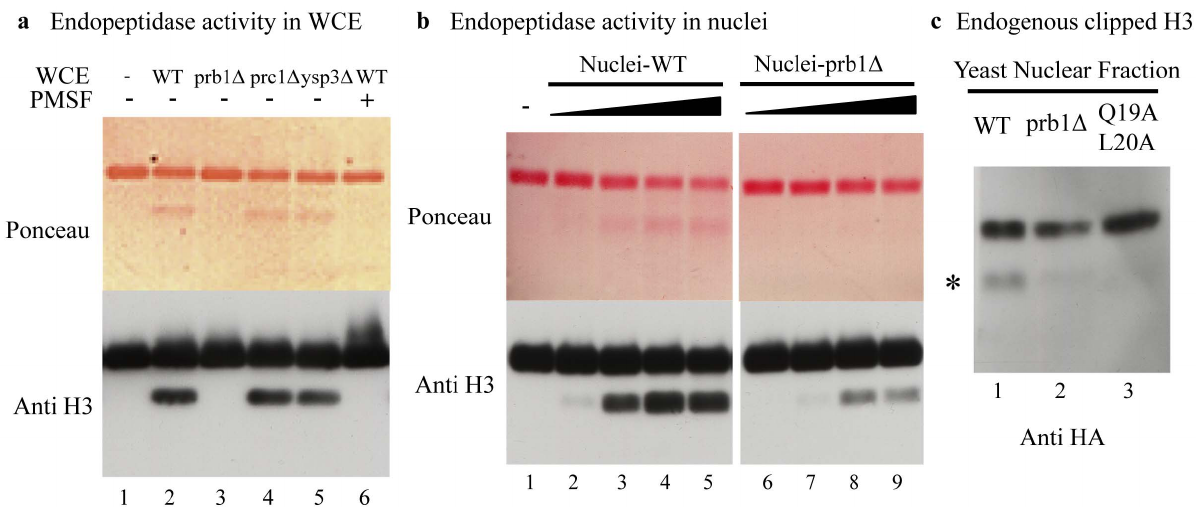
Figure 2. PRB1 is required to cleave histone H3 at its N-terminus invivo. (a) PRB1 is essential for the H3 endopeptidase activity in whole cell extracts of early stationary phase cells. Whole cell extracts from WT, prb1 D , prc1 D and ysp3 D were assayed for endopeptidase activity. Clipping was assayed by western blot with antibody against the H3 C-terminus. (b) PRB1 is required for H3 endopeptidase activity in nuclei. Nuclei from WT and prb1 D cells were assayed for endopeptidase activity. Clipping was assayed by western blot with antibody against the H3 C-terminus. The nuclei gradient is represented by 4 fold dilutions. (c) Endogenous truncated histone H3 level was decreased in the prb1 D strain. Nuclear fractions were purified from WT, prb1 D and H3 Q19A, L20A mutant strains in early stationary phase and truncated H3 levels were measured by western blot with antibody against the HA tag.